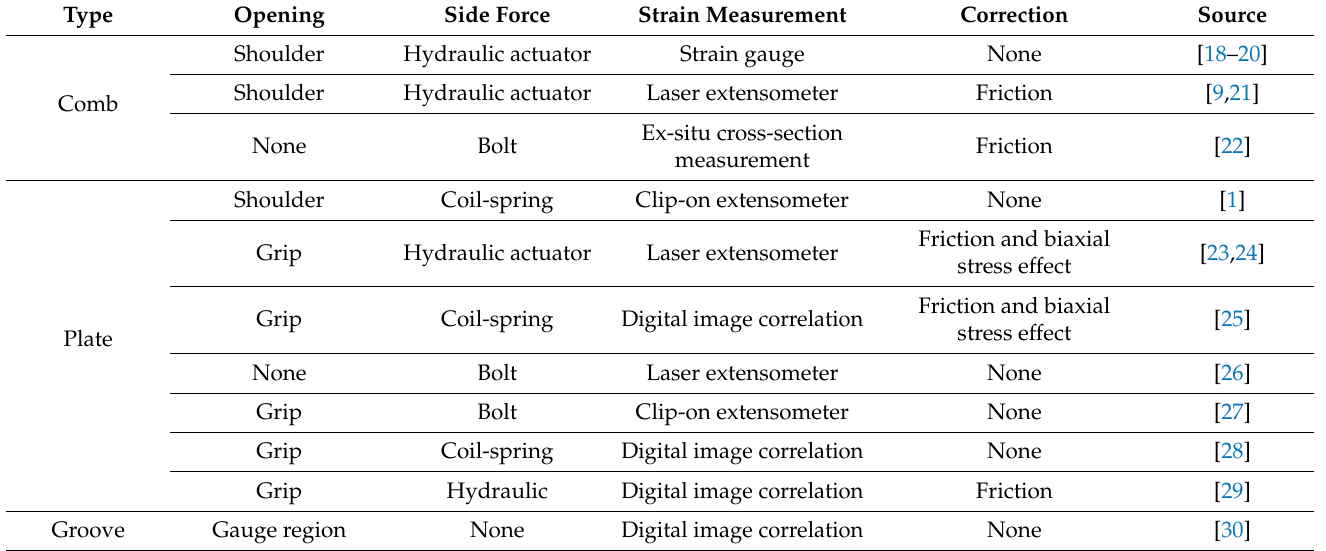
Table 1. In-plane sheet compression test